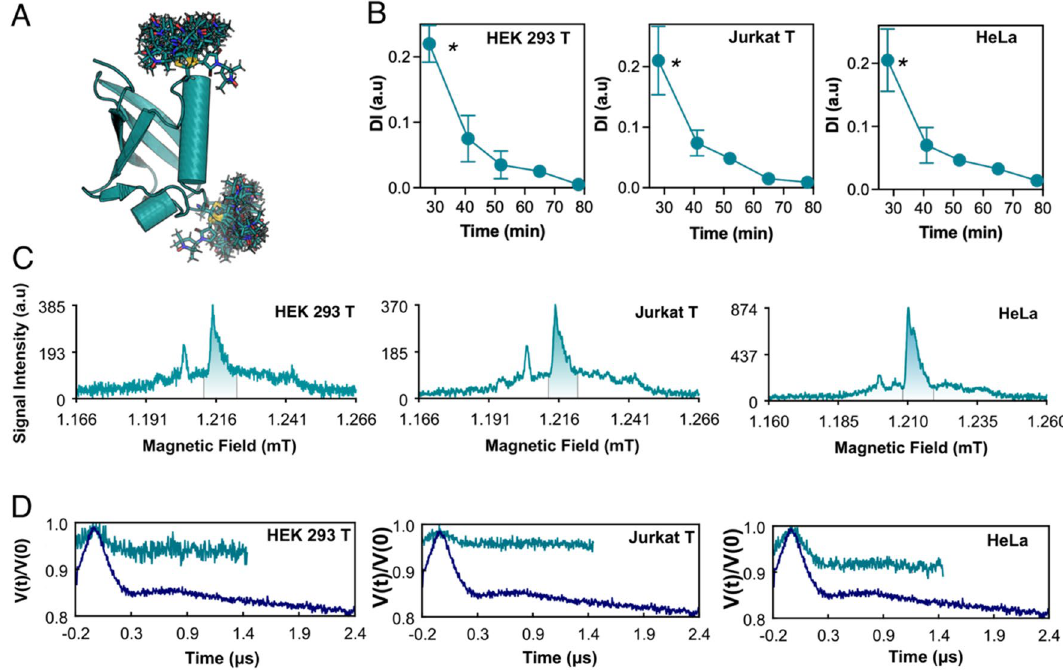
Figure 4. ( A ) Model structure of human ubiquitin protein labelled with Maleimide DOTA Gadolinium tag in the S20C and G35C position derived from MMM 44 . ( B ) Nitroxide double integral signal decay over time extracted from the RT cw-EPR X-band spectra for the Ubiquitin S20C/G35C ma-Px delivered cells. The spectra DI (Double Integral) were plotted against the overall time course. The first point time point take into